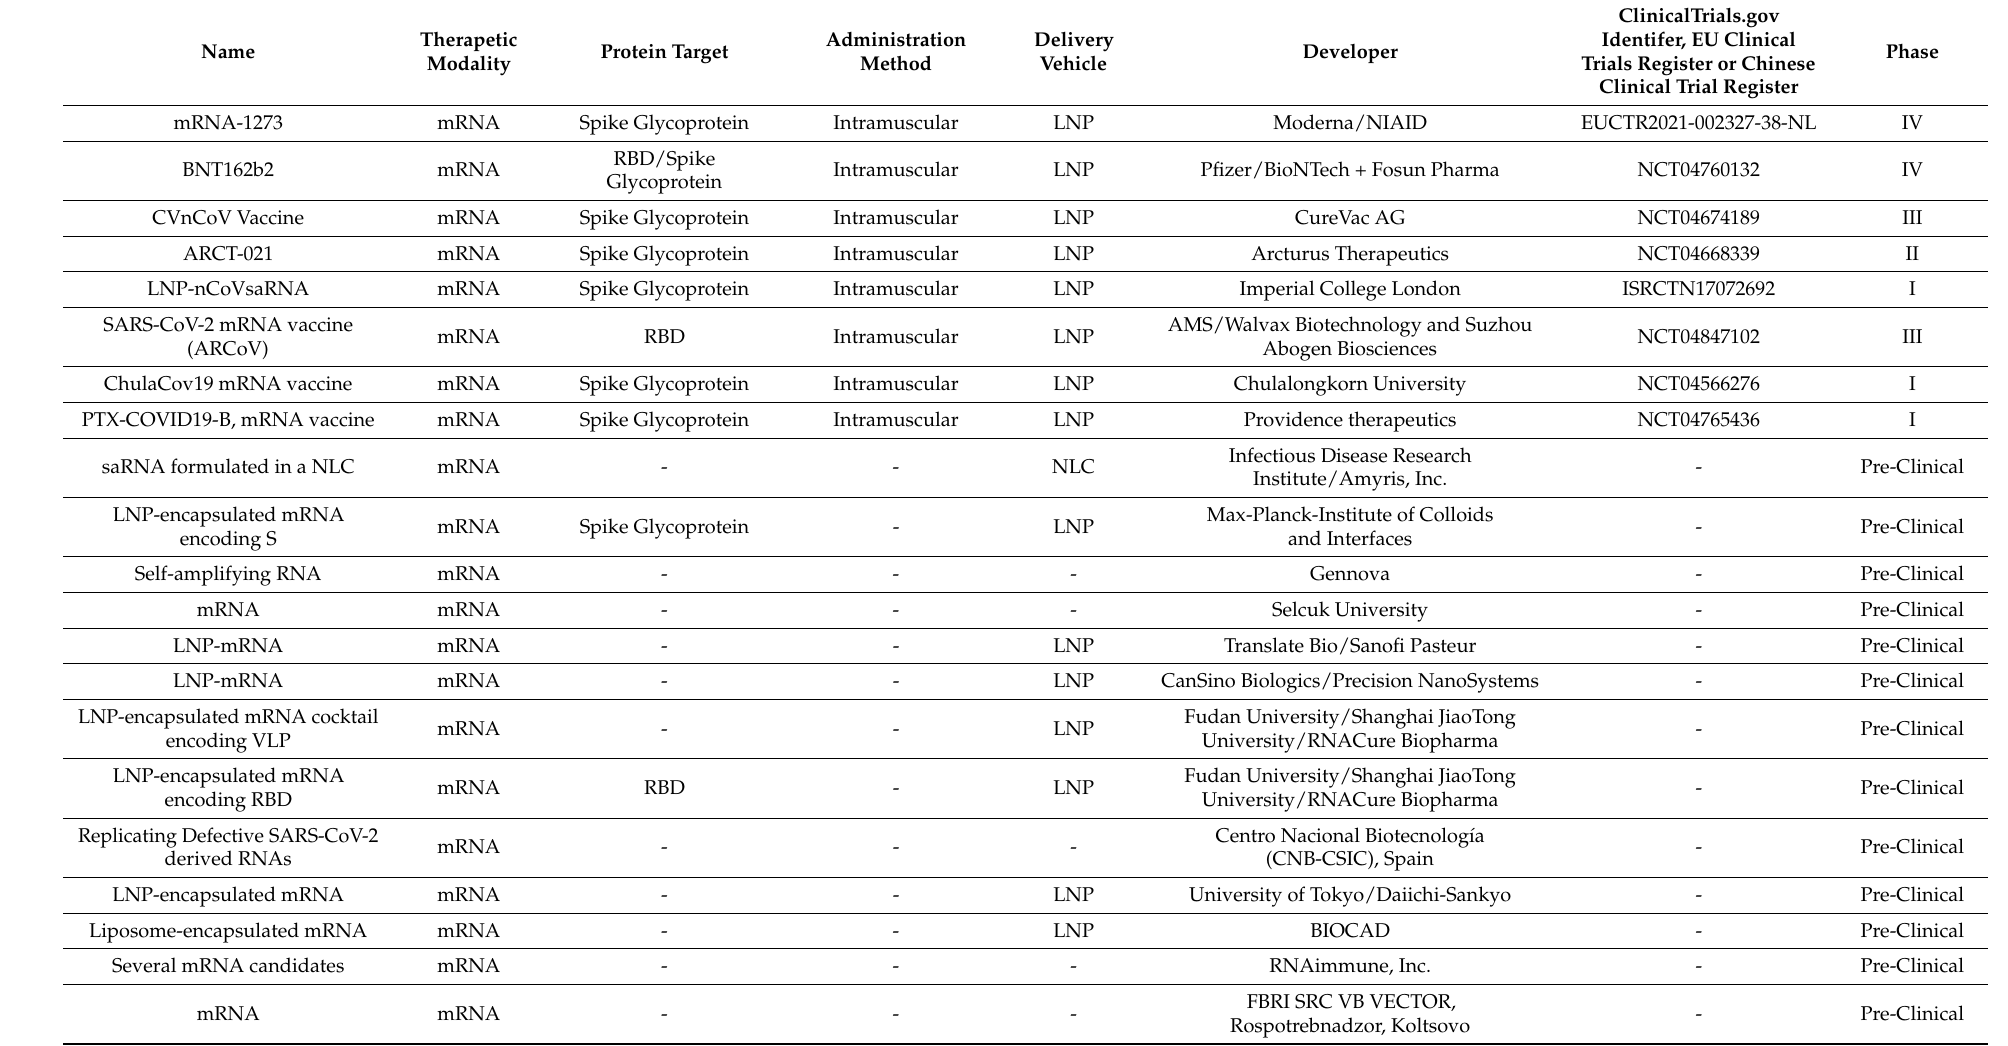
Table 6. mRNA vaccines and new candidates for COVID-19